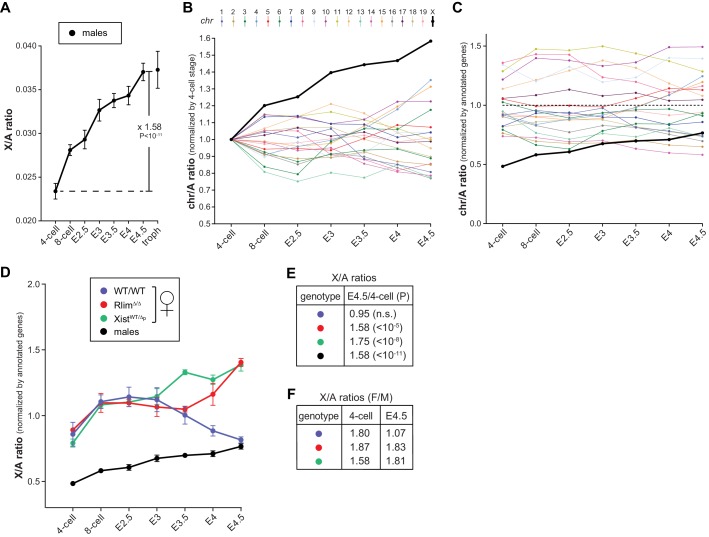
Dynamics of X-linked gene expression in preimplantation embryos.(A) X/A expression profile in males. Male data were collected from males of RlimKO/WT and XistKO datasets. For each embryo, the total FPKM expression of X-linked genes was divided by the total FPKM expression of autosomal genes. Shown is the average X/A values for each developmental stage. The increase of 1.58-fold in X/A values from the 4-cell stage to E4.5 is highly significant (P<10–11; Student’s t-test). (B) Comparison of gene expression profiles from chromosomes 1 to 19 and X during male pre/peri-implantation development. Data were collected from male embryos of both datasets. At each developmental stage the total FPKM expressed from each chromosome was divided by the total FPKM expression of all autosomal genes. Values obtained for each chromosome at the 4-cell stage are set to 1. (C) Dynamics of the relative gene expression expressed from single chromosomes in male embryos. The total FPKM/total number of annotated genes of each chromosome was divided by the total FPKM of all autosomal genes/total number of autosomal genes. Male data were collected from all males of both datasets. Note that expression from the X is markedly lower at early stages (around x0.5), increasing to x0.77 to that of the average autosome (1.0; dotted line) by E4.5. (D) Female and male X/A expression profiles normalized to annotated genes. The total FPKM/total number of annotated genes on the X was divided by the total FPKM of all autosomal genes/total number of annotated autosomal genes. Female genotypes are indicated. (E) The E4.5/4-cell stage ratios of X/A values are shown for WT/WT, XistWT/Δ and RlimΔ/Δ females as well as males. P values (Student’s t-test) are indicated; n.s. = not significant. (F) Comparison of X/A values according to gender: F/M ratios of X/A values at the 4-cell and E4.5 stages are shown for WT/WT, XistWT/Δ and RlimΔ/Δ. Error bars indicate SEM.